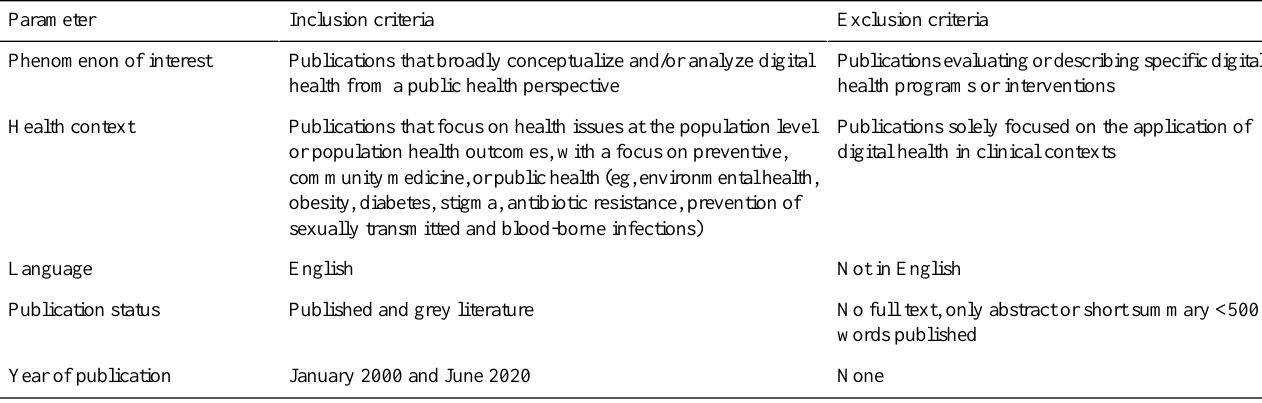
Table 1. Eligibility criteria.